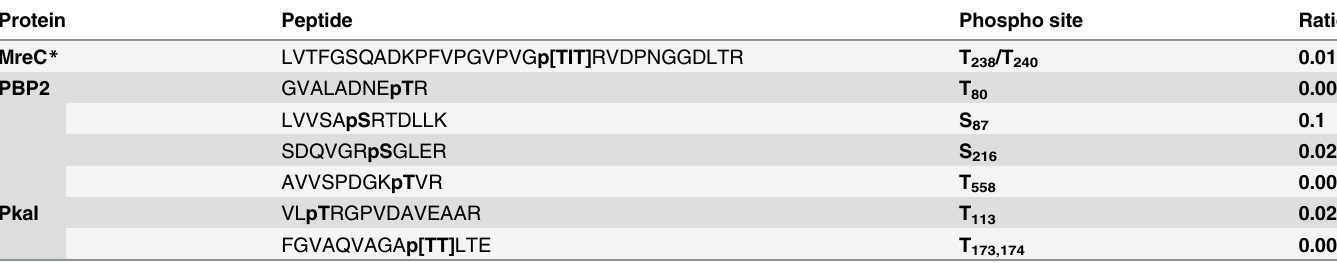
§ Most probable phosphosites/phosphorylated region, as identi fi ed by LC-MS/MS, are highlighted by bold letters. Unlocalized phosphorylation sites are situated in regions marked with brackets. Phosphopeptide ratio represents intensity of non-phosphorylated peptide divided by the intensity of phosphorylated